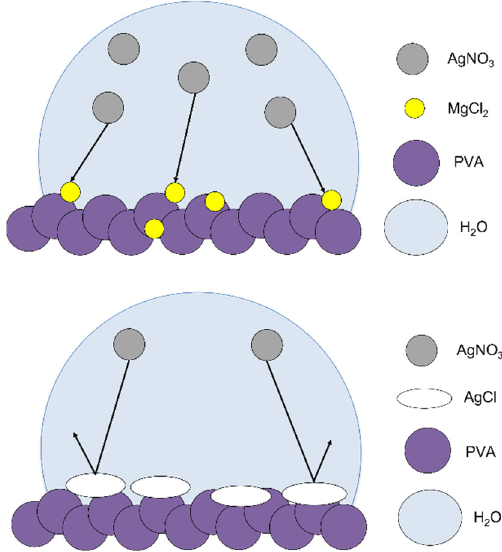
Figure 4. Proposed mechanism of loaded salt as a barrier to silver staining on PVA films.